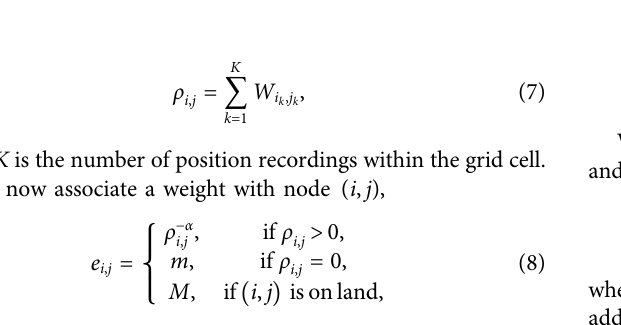
FIGURE 2 | (A) Data set B showing AIS position recordings with positions in degrees relative to the origin. (B) A selected subset of area B spanning 3 + in both the longitudinal and latitudinal directions, transformed into a grid of dimensions 334 × 334 with cell size 1000 × 1000 m 2